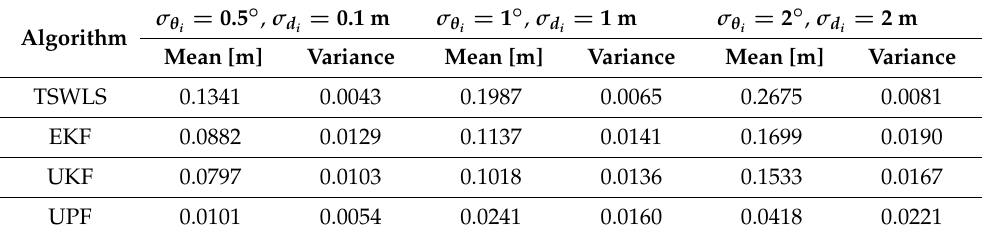
Figure 18. The CDF of RMSE for different algorithms in LOS scenario ( σ θ Table 3. The statistical parameters of positioning error in LOS